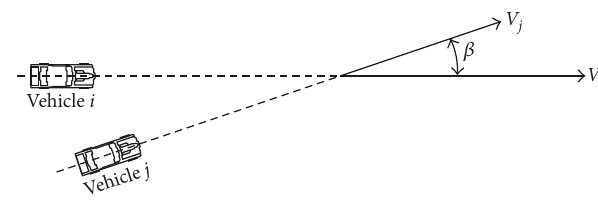
Figure 1: Collision of two vehicles at an angle of β